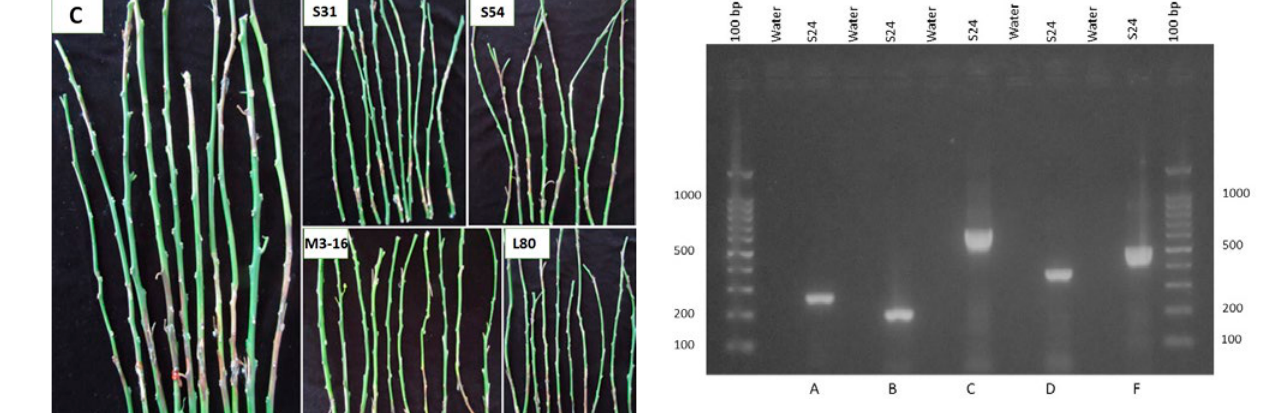
Figure 5. PCR amplification products of antibiotic biosynthetic genes in Bacillus amyloliquefaciens (S24), with primers (A) fengycin (FENDF/R) 269 bp; (B) surfactin (SRFAF/R) 201 bp; (C) iturin A